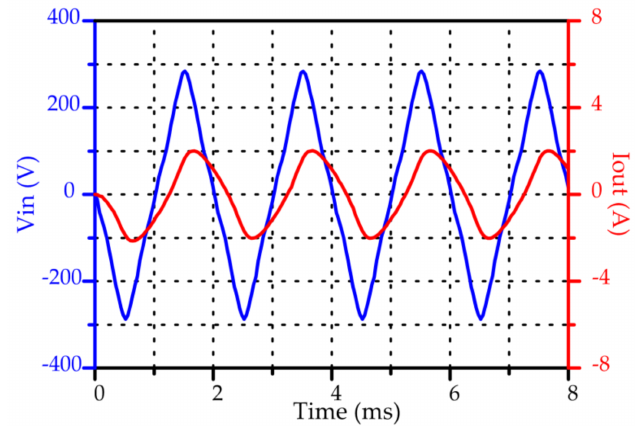
Figure 15. Input voltage and output current waveforms at 2500 r/min.